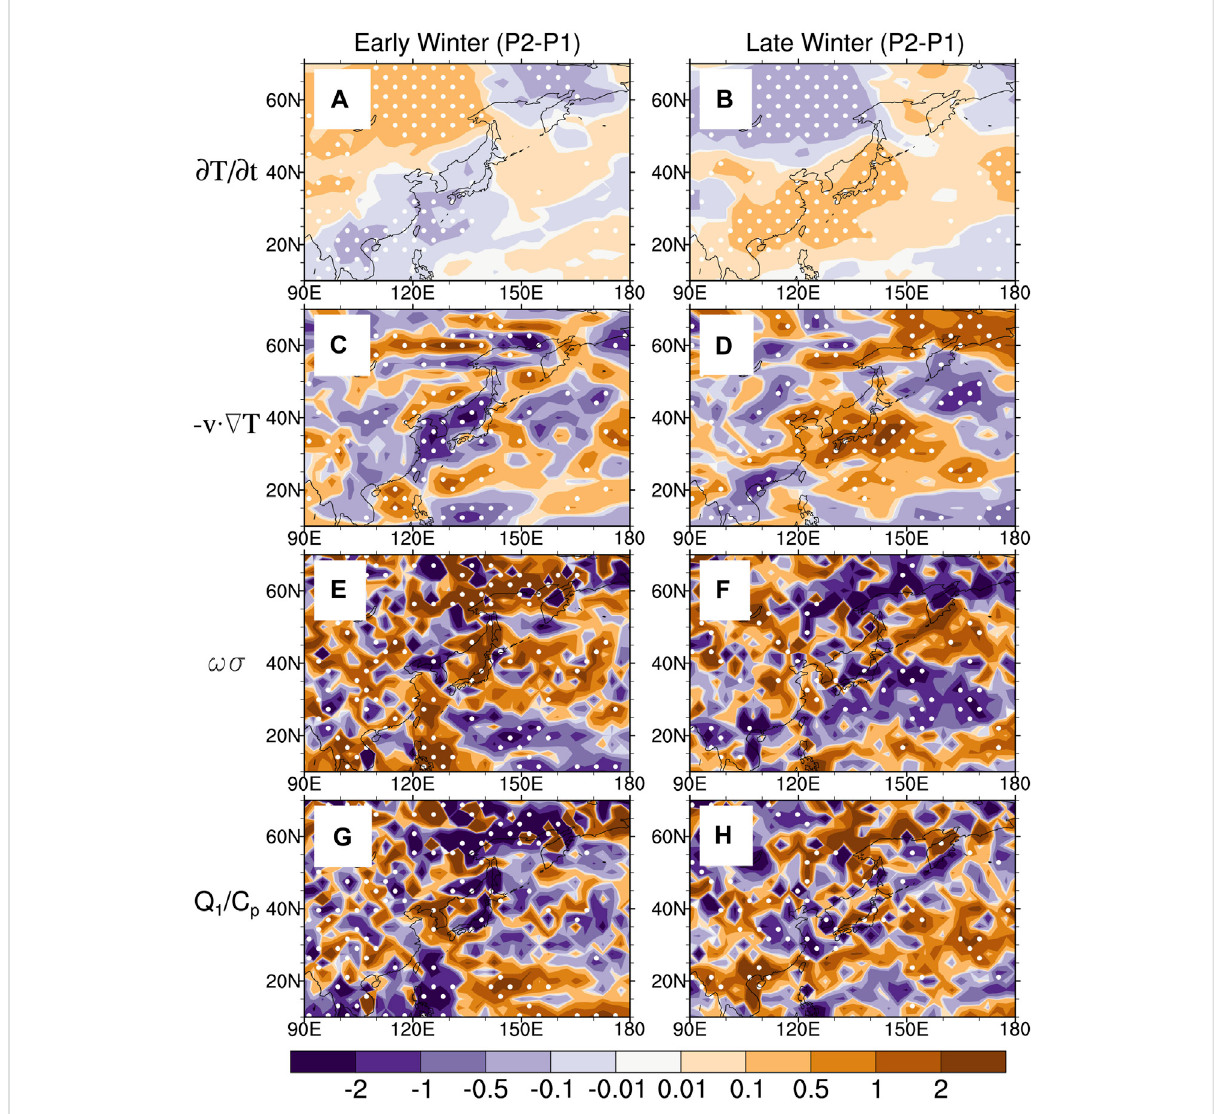
FIGURE 9 Difference in each contribution of the temperature tendency equations (shading; units: 10 -4 Ks -1 ) between P2 and P1 in early and late winters at 850 hPa. (A,B) , (C,D) , (E,F) , (G,H) representthechangeintemperatureovertime,thetemperatureadvectionterm,theadiabatictermandthediabatic heating term, respectively. The white dots represent p <